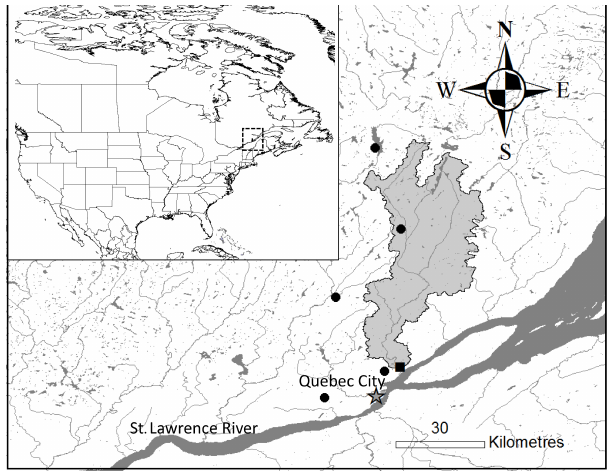
Figure 3. Geographical location of the Montmorency watershed. The black dots represent the available meteorological stations and the black square is the streamflow gauging